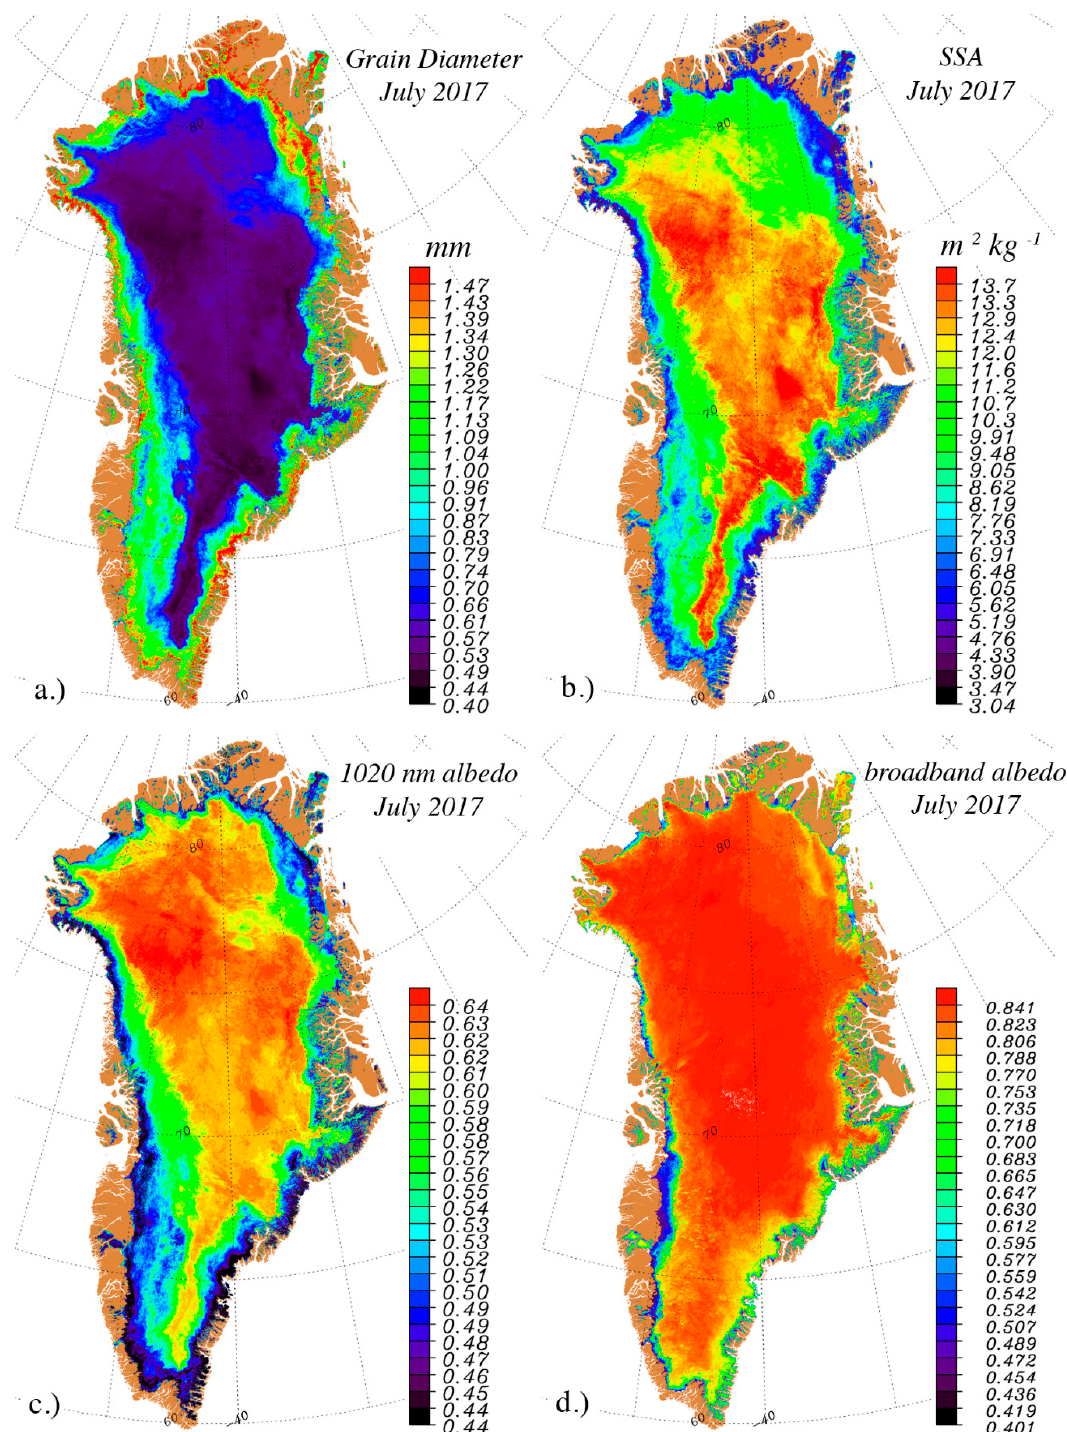
Figure 19. Example monthly statistics from OLCI-derived snow physical properties; ( a ) grain diameter; ( b ) specific surface area; ( c ) planar albedo at 1020 nm; ( d ) broadband albedo (300–2500 nm).